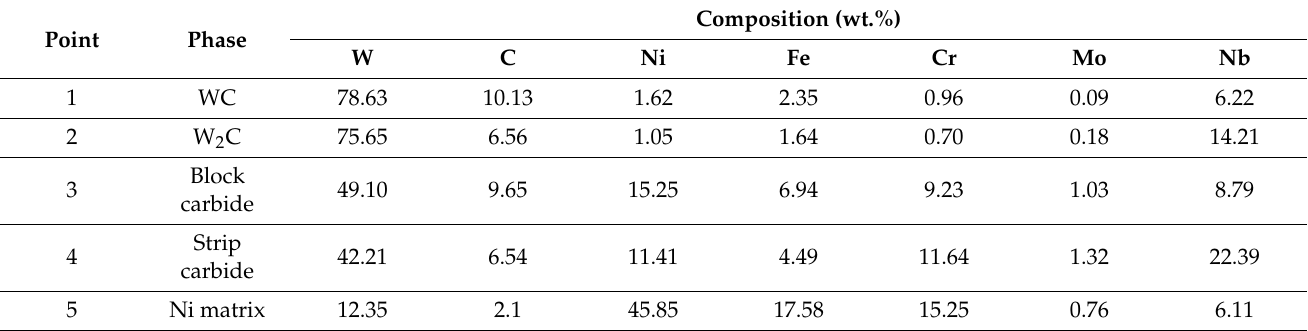
Table 4. Chemical compositions of different phases in the composite coating.